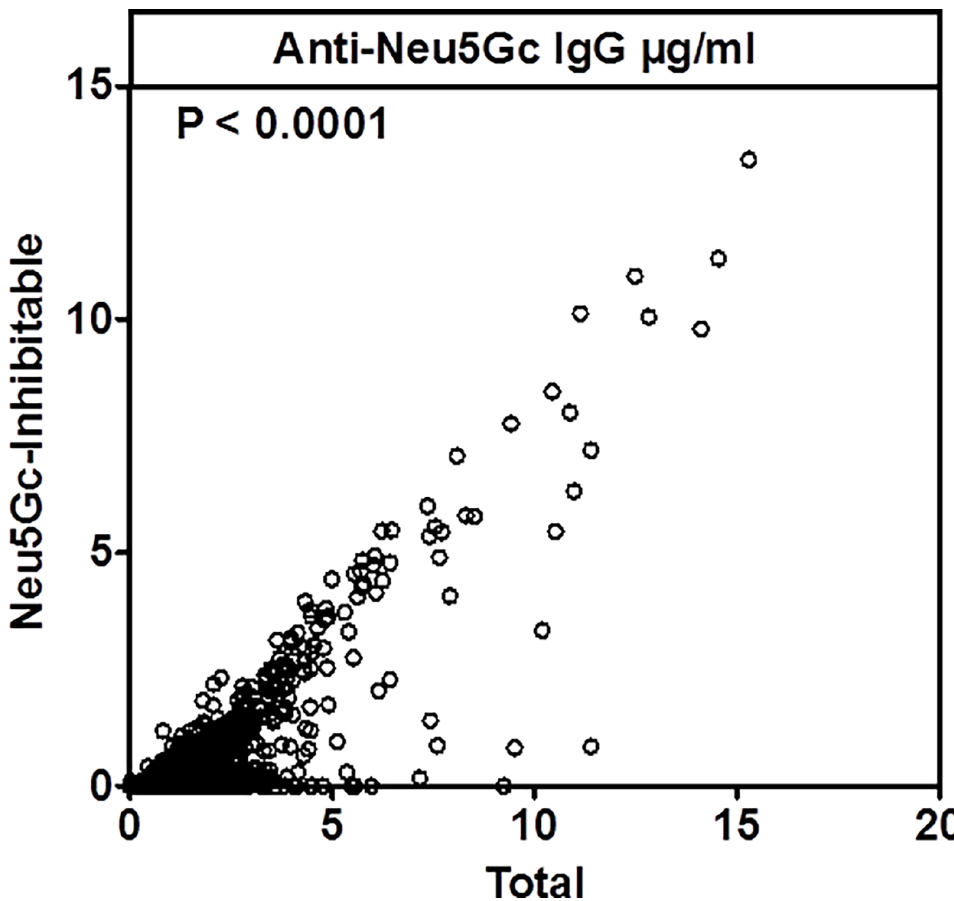
epitopes as the target antigen (N = 46). A strong correlation was observed between total and inhibitable anti-Neu5Gc IgG titers in the NHS cohort (Spearman r =